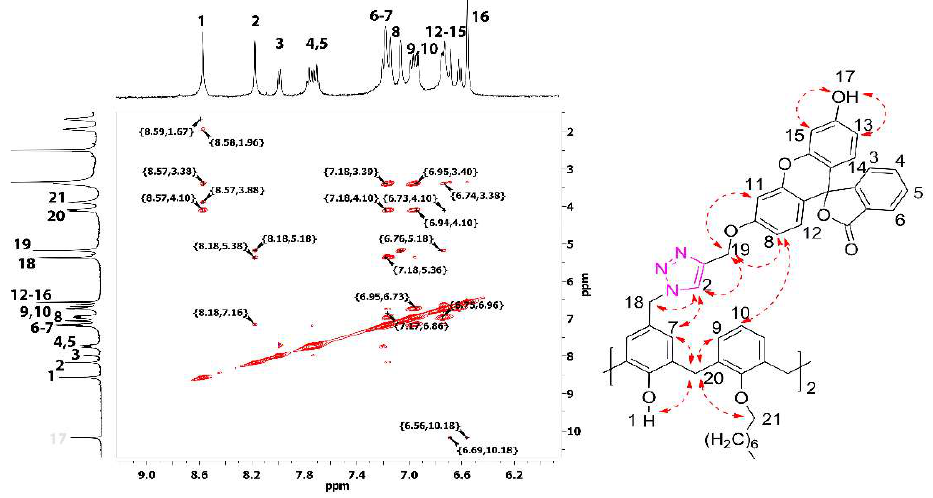
Figure 1. Fragment of the 1 H– 1 H NOESY NMR spectra of 5 (DMSO–d 6, 25 °С).